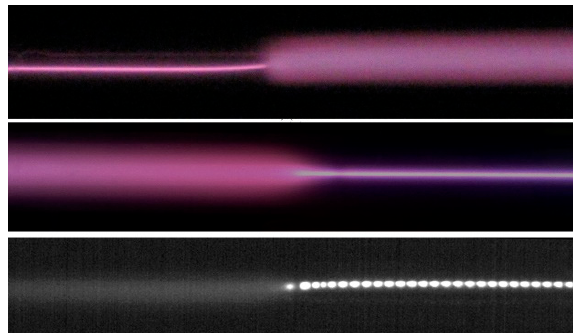
Figure 13. Two upper panels are the photos of the transition region between diffuse and constricted parts of discharge. The lower panel is a 120 µs exposure CMOS camera image. In all cases, the cathode is on the left. Ar + 0.075%, P = 80 Torr [19] (© 2011 IEEE).